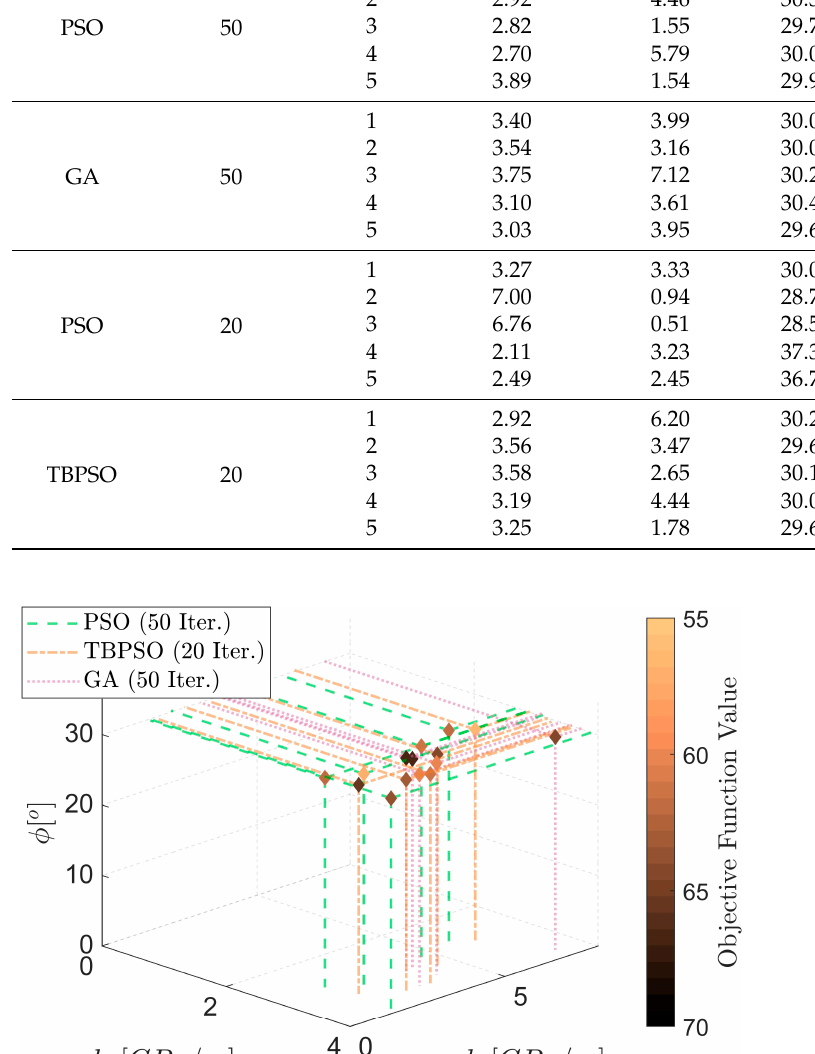
Figure 19. Failure mode of Pulatsu’s geometry for best set of material parameters using objective function 2; the colour legend represents the displacements in metres.